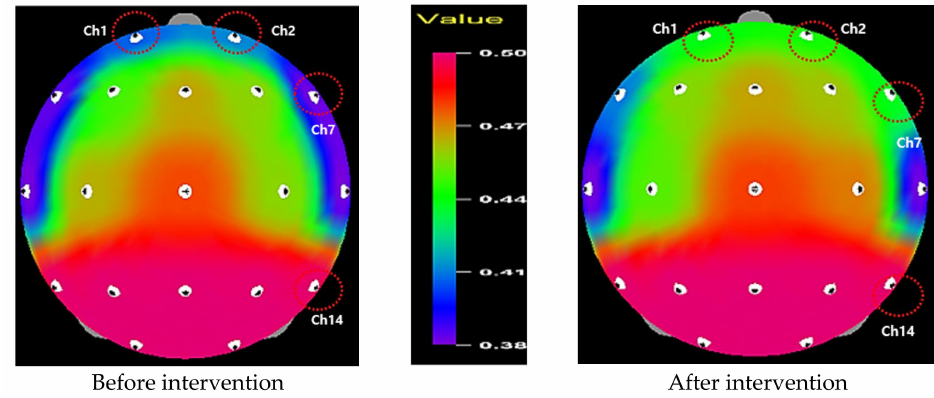
Figure 2. Relative alpha wave.